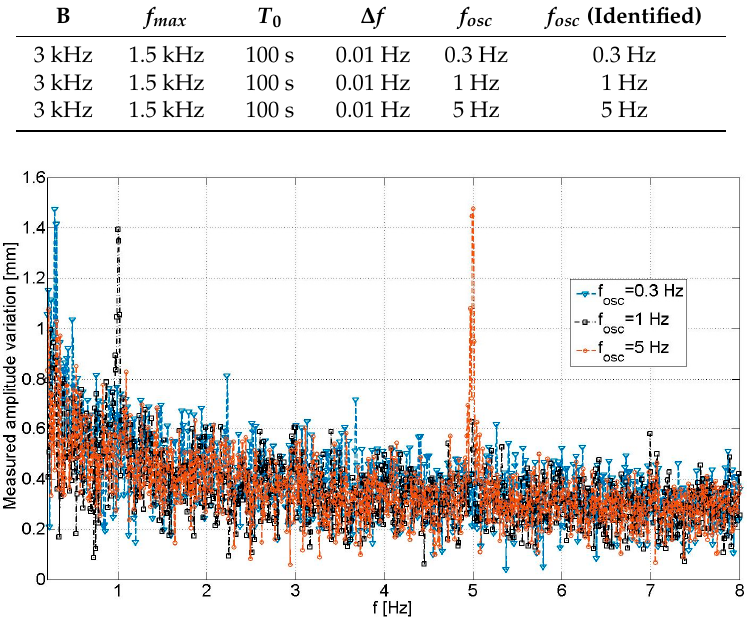
Table 7. Parameters and results of the second experimental validation test.